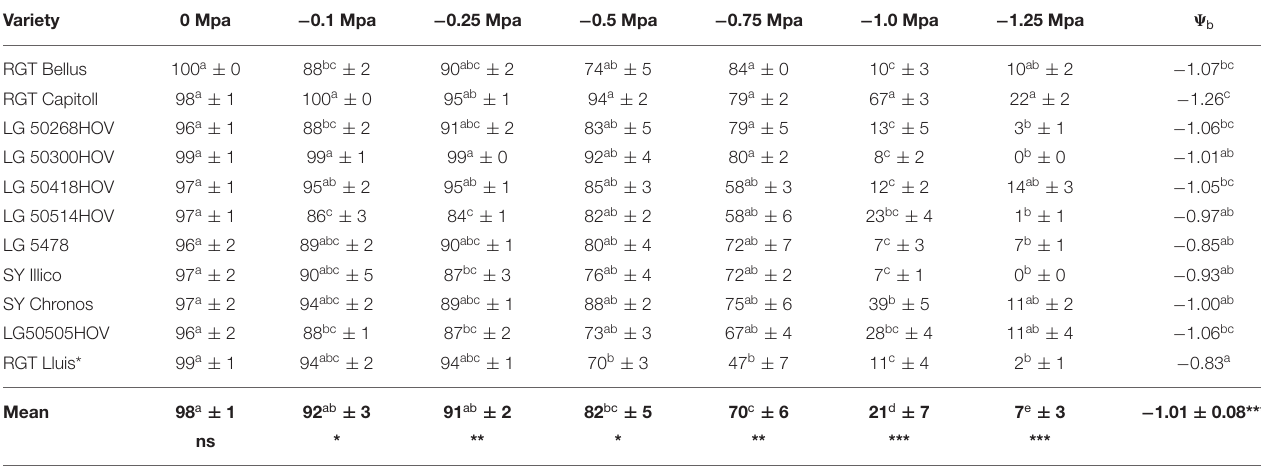
TABLE 4 | Final average rate of seed germination ( ± standard deviation) of 11 hybrid oilseed varieties of sunflower tested under laboratory conditions in 2020 under a wide range of water potentials.